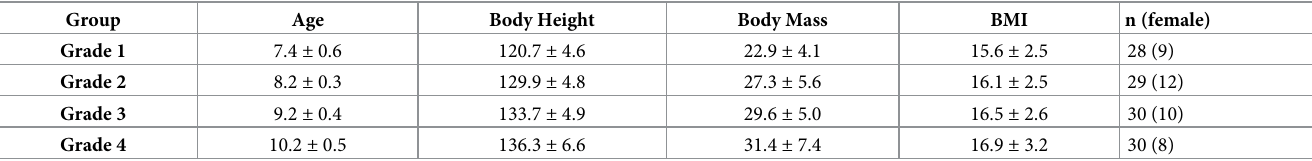
Table 1. Descriptive statistics for each grade group (mean ±